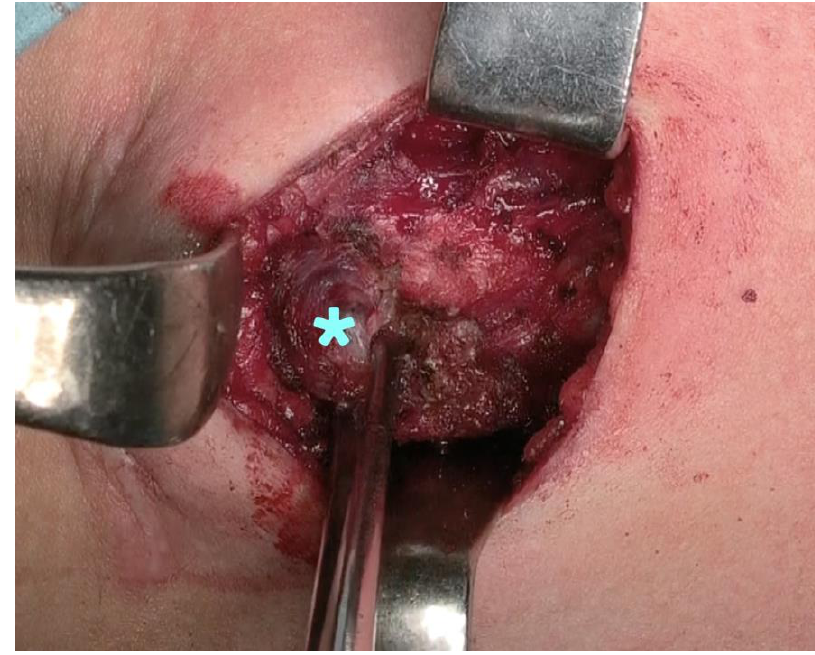
Figure 3. Residual thyroid tissue (*).